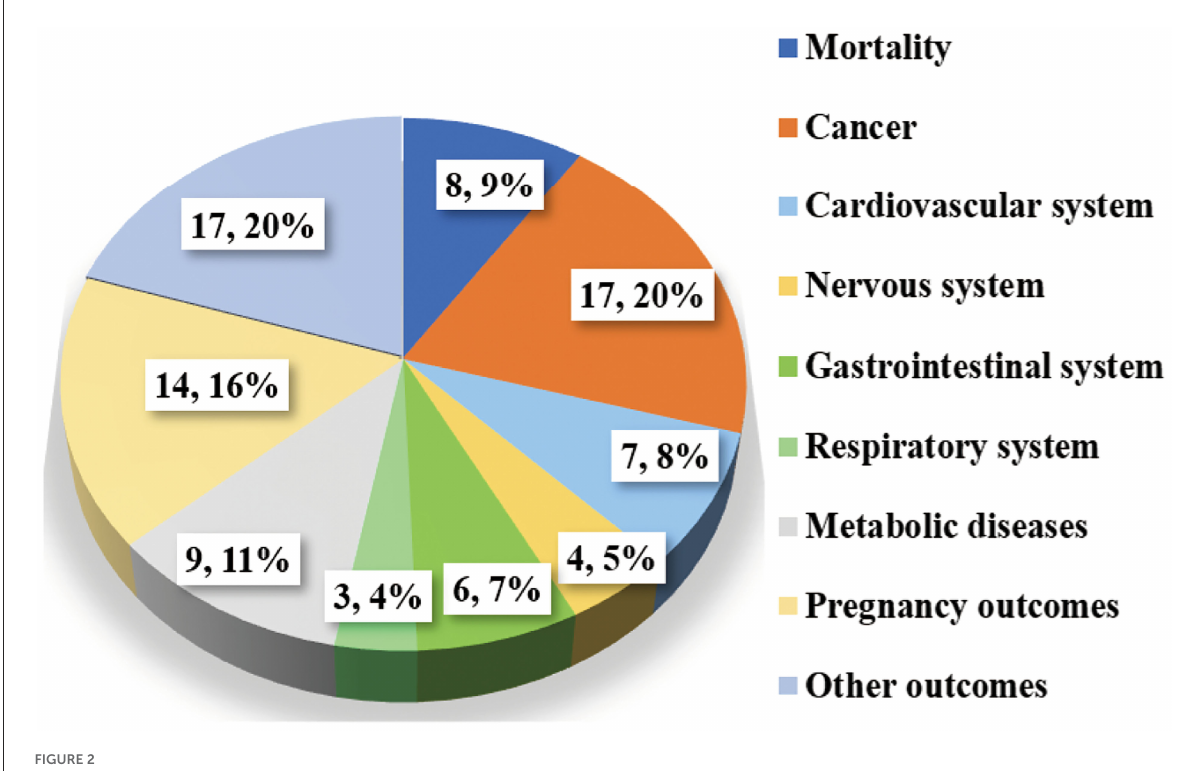
FIGURE2 Map of medical end points associated with psoriasis.